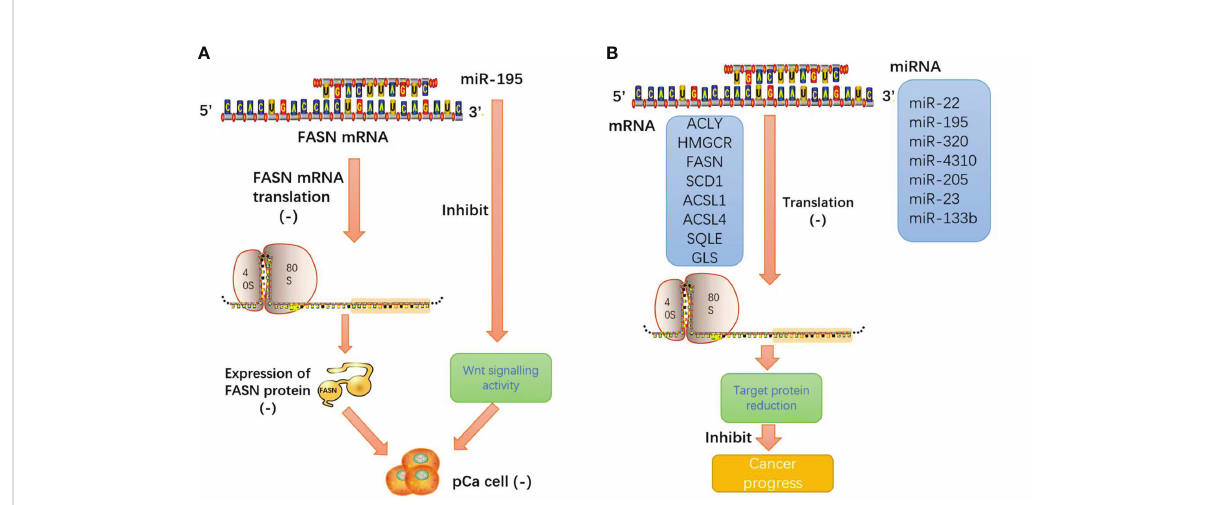
FIGURE 6 (A) miRNA-195 inhibits pancreatic cancer cell proliferation and invasion by regulating the FASN/Wnt signaling pathway; (B) miRNA induces the cleavage and degradation of target mRNA through base pairing with the 3 ′ untranslated region (3 ′ UTR) of mRNA. The result is that the protein expression products of target mRNA and the malignant behavior of tumors are